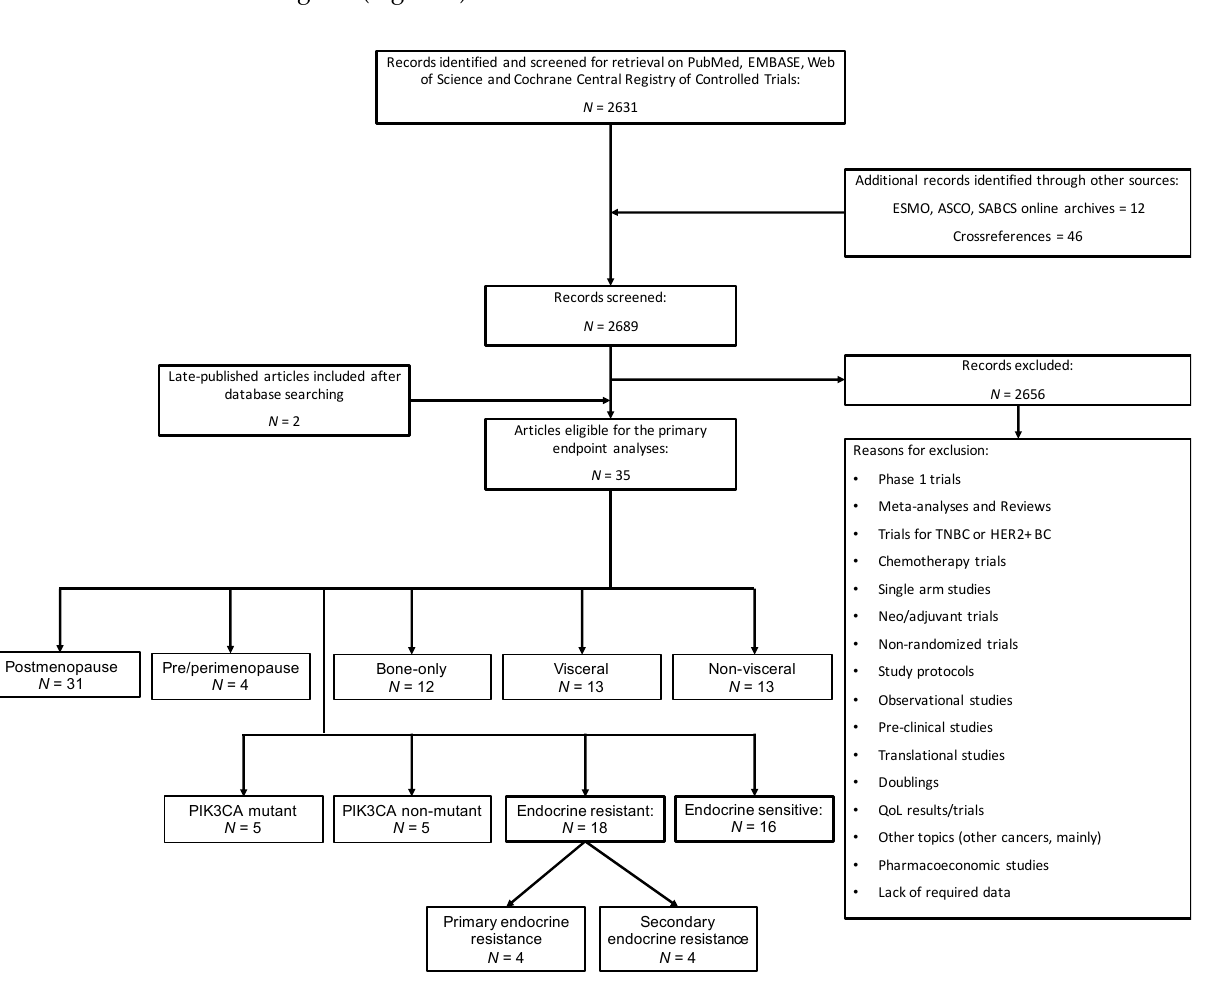
Figure 1. PRISMA diagram.